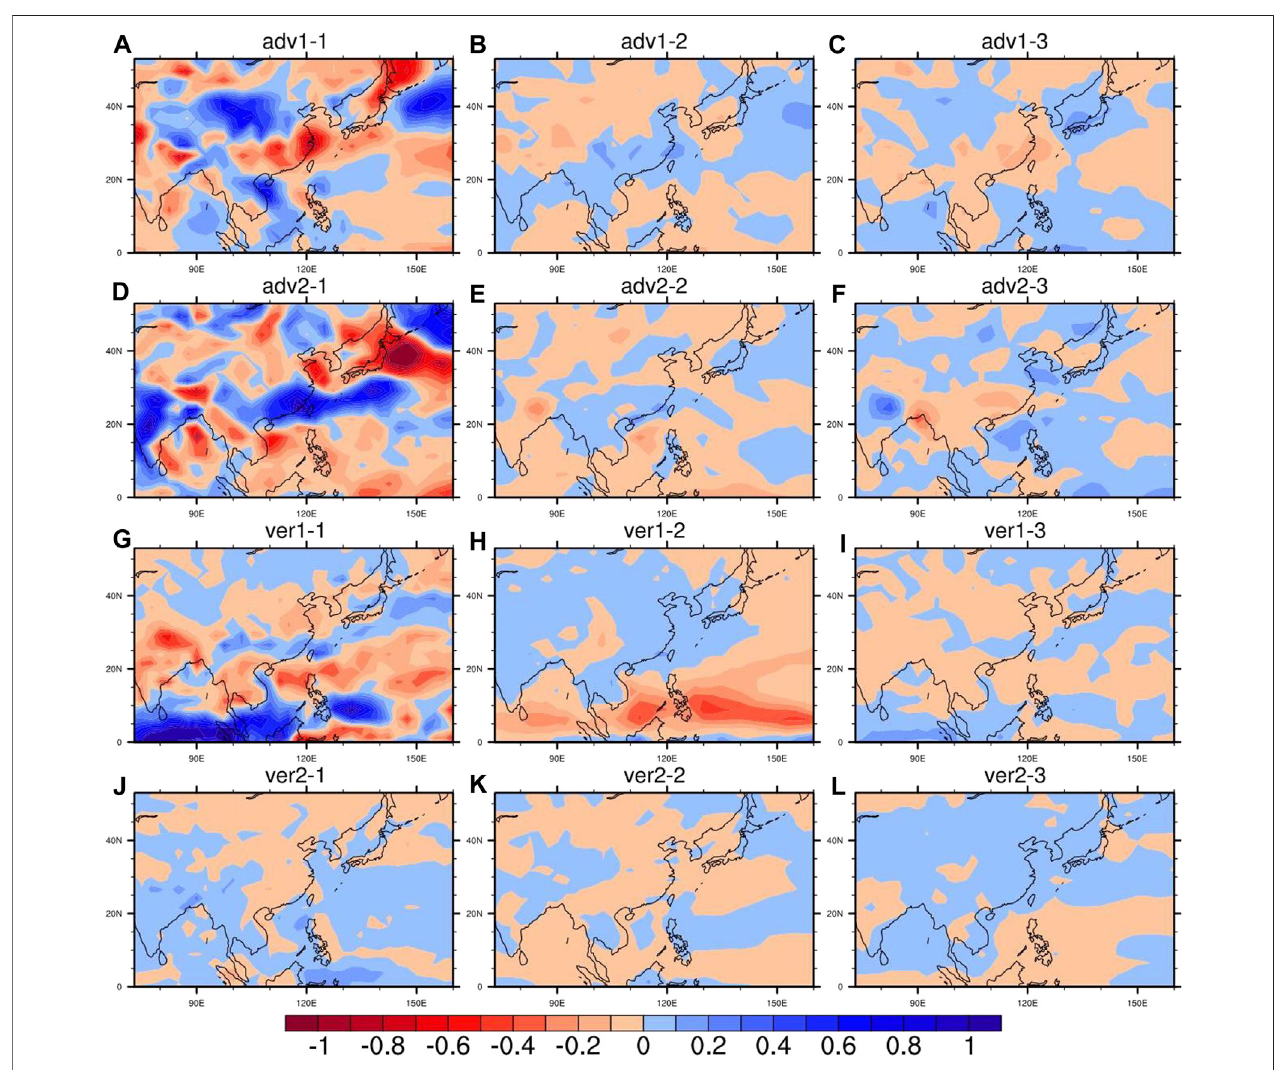
FIGURE 11 | The MME changes of the moisture budget for different terms (A) − Δ V E · ∇ q p , (B) − V Ep · ∇ ( Δ q ) , (C) − Δ V E · ∇ ( Δ q ) , (D) − V p · ∇ ( Δ q E ) , (E) − Δ V · ∇ ( q Ep ) , (F) − Δ V · ∇ ( Δ